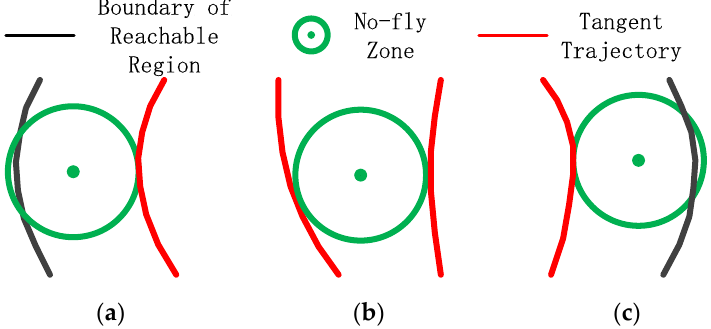
Figure 6. The relationship between No-fly zones and Reachable region: ( a ) represents the left boundary of the no-fly zone intersects the reachable region; ( b ) represents the reachable region fully includes the no-fly zone; ( c ) represents the right boundary of the no-fly zone intersects the reachable region.